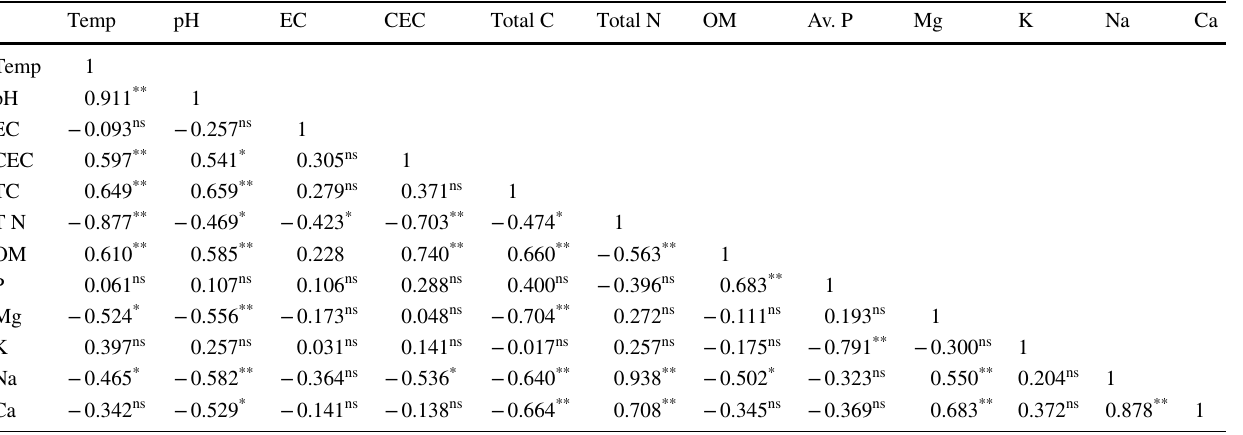
ns not significant, OM organic matter *,**Correlation is significant at the 0.05,